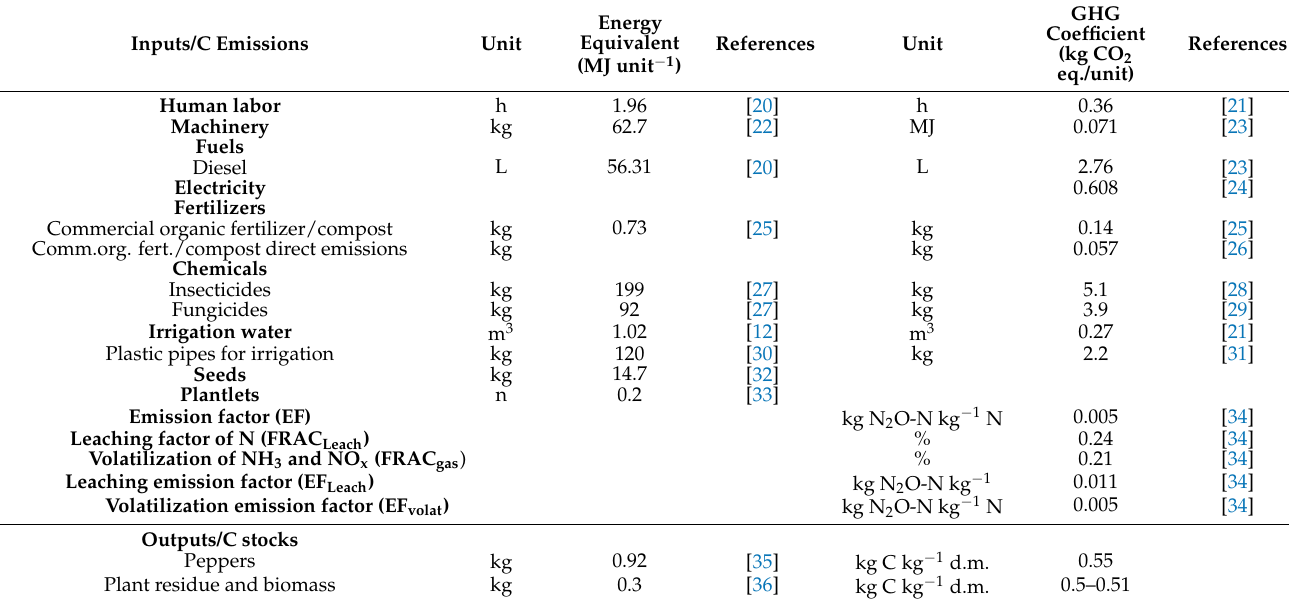
Table 2. Energy equivalents and greenhouse gases coefficients (GHG) of each input and output for energy equivalents and of C emissions and C stocks for GHG coefficients, in crop